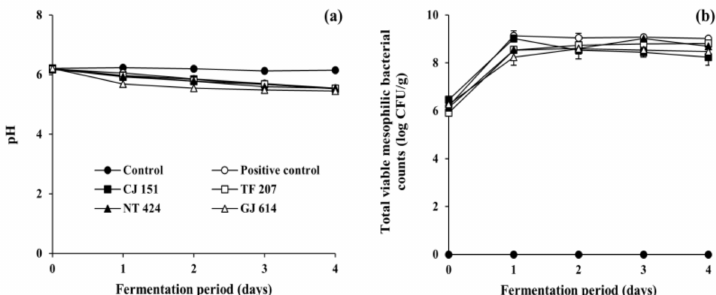
Figure 2. Changes in ( a ) pH and ( b ) total viable mesophilic bacterial counts of soybeans fermented with arbutin-producing B. subtilis strains. • : control without an inoculum, with B. subtilis KCTC 3135, (cid:4) : experimental sample inoculated with B. subtilis CJ 151, (cid:3) : experimental sample inoculated with B. subtilis TF 207, (cid:78) : experimental sample inoculated with B. subtilis NT 424, (cid:52) : experimental sample inoculated with B. subtilis GJ 614. Error bars indicate the minimum and maximum values of duplicate